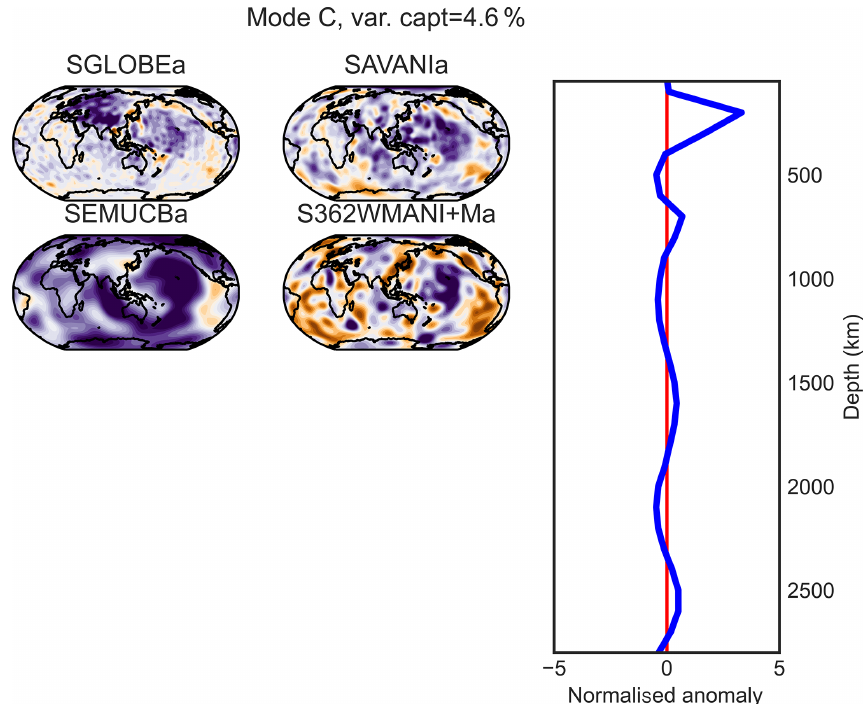
Figure E3. PC C (maximum at 200km of depth) of the combined analysis of the anisotropic models.